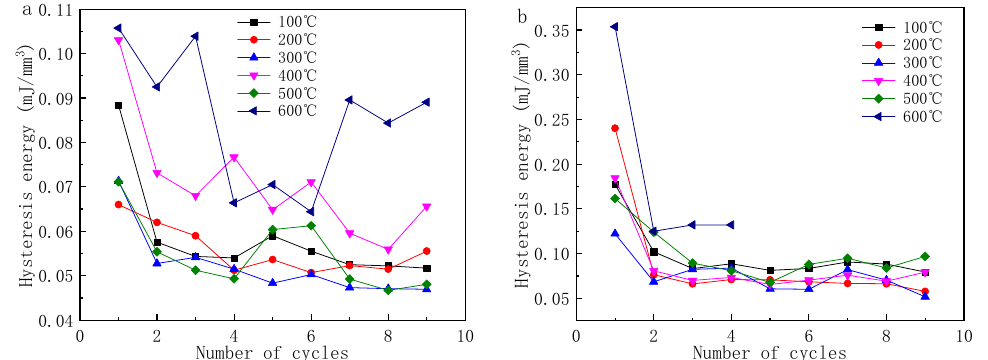
Figure 11. Variations of hysteresis energy with number of temperature and stress cycles at six upper limit cyclic temperatures ( a ) upper limit of cyclic stress = 70% of UCS, ( b ) upper limit of cyclic stress = 85% of UCS.